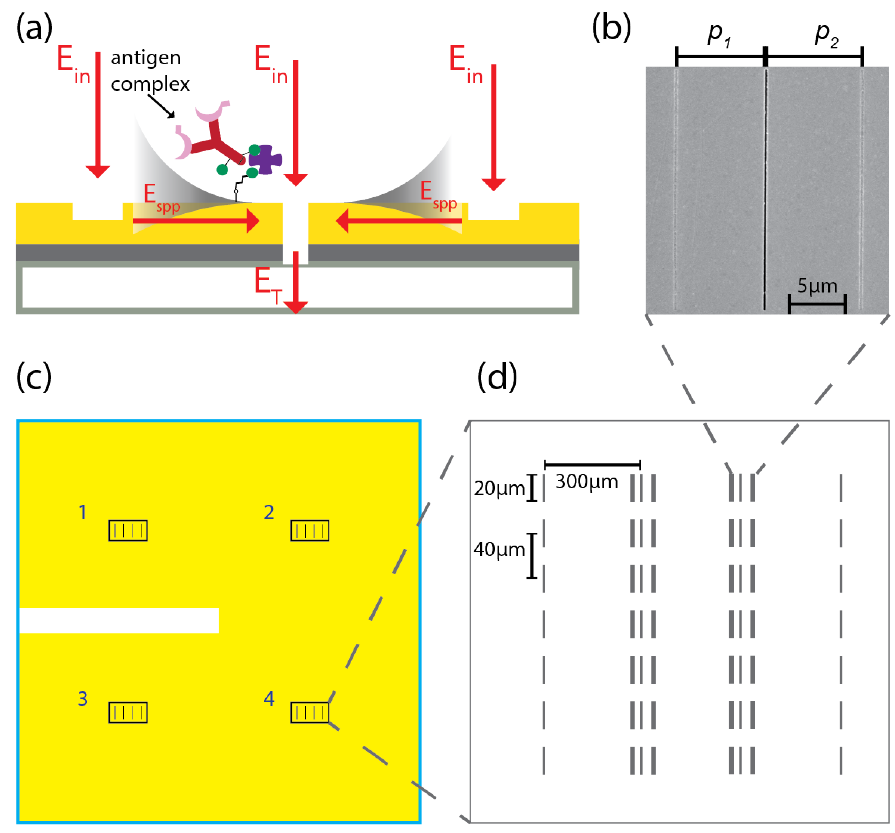
Figure 1. Design for TREM2 sensor chip based on plasmonic interferometry. ( a ) Cross-section schematic of the groove-slit-groove (GSG) architecture, which shows a slit flanked by two grooves, from which SPPs are excited by light diffraction and propagate towards the slit aperture, where they interfere and are then transmitted back into free space for far-field detection; diagram includes an example of an antigen complex, further described in Figure 2. The bottom slab represents quartz, the middle titanium, and the top layer gold. ( b ) Scanning electron micrograph (SEM) of a GSG interferometer with p 1 = 7.65 µ m, p 2 = 8.15 µ m. ( c ) Schematic of plasmonic interferometer sensor chip layout. The chip contains four nominally identical sensing spots enabling multiplex sensing applications. The yellow area indicates quartz covered by gold and the blank area is an uncoated quartz window used for optical alignment. ( d ) Schematic of a representative active sensing area. Each sensing area contains two columns of single slits and two columns of nominally identical asymmetric GSG interferometers with separation distance of 300 µ m. The slit/grooves in each interferometer are ∼ 20 µ m long and, within each column, the distance between two adjacent interferometers is ∼ 40 µ